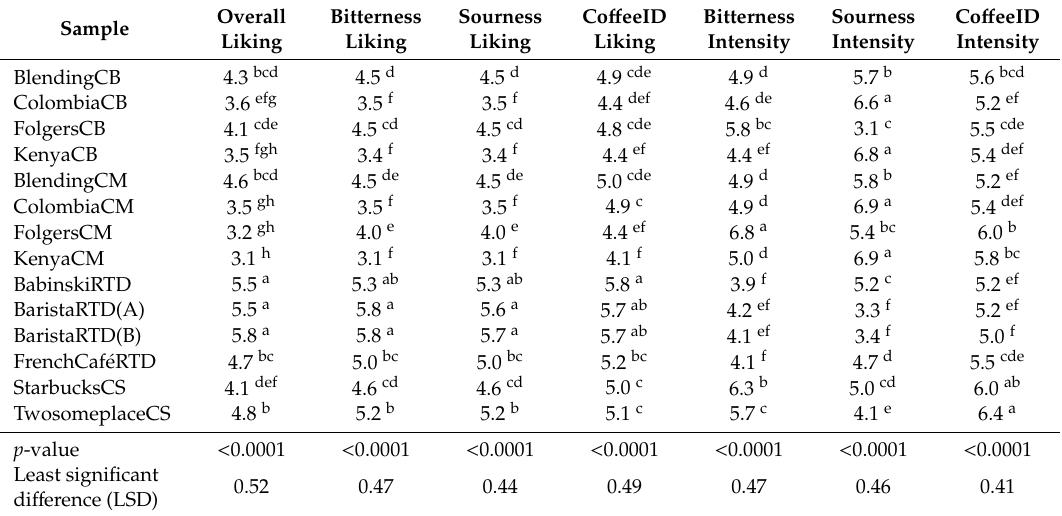
Table 3. Analysis of variance of consumers’ liking and perceived intensity for co ff ee